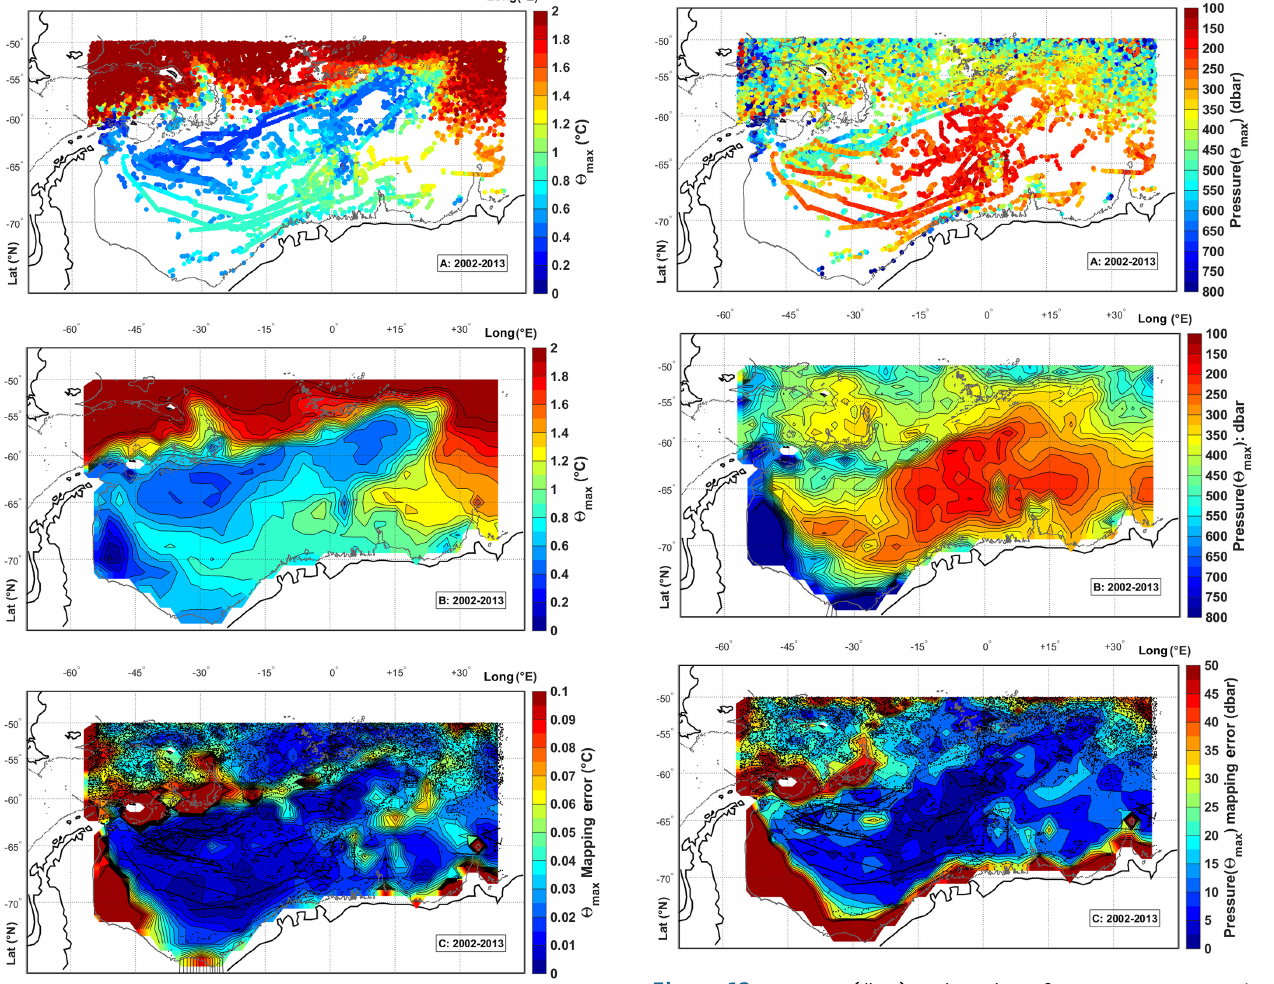
Figure 11. Conservative temperature ( ◦ C) at the sub-surface tem- perature maximum for the entire time period, where panel (a) shows the original float data, panel (b) shows the objectively mapped field and panel (c) shows the mapping error for the mapped field (pro- file locations are marked as black dots). The grey contour shows the 2000m isobath.